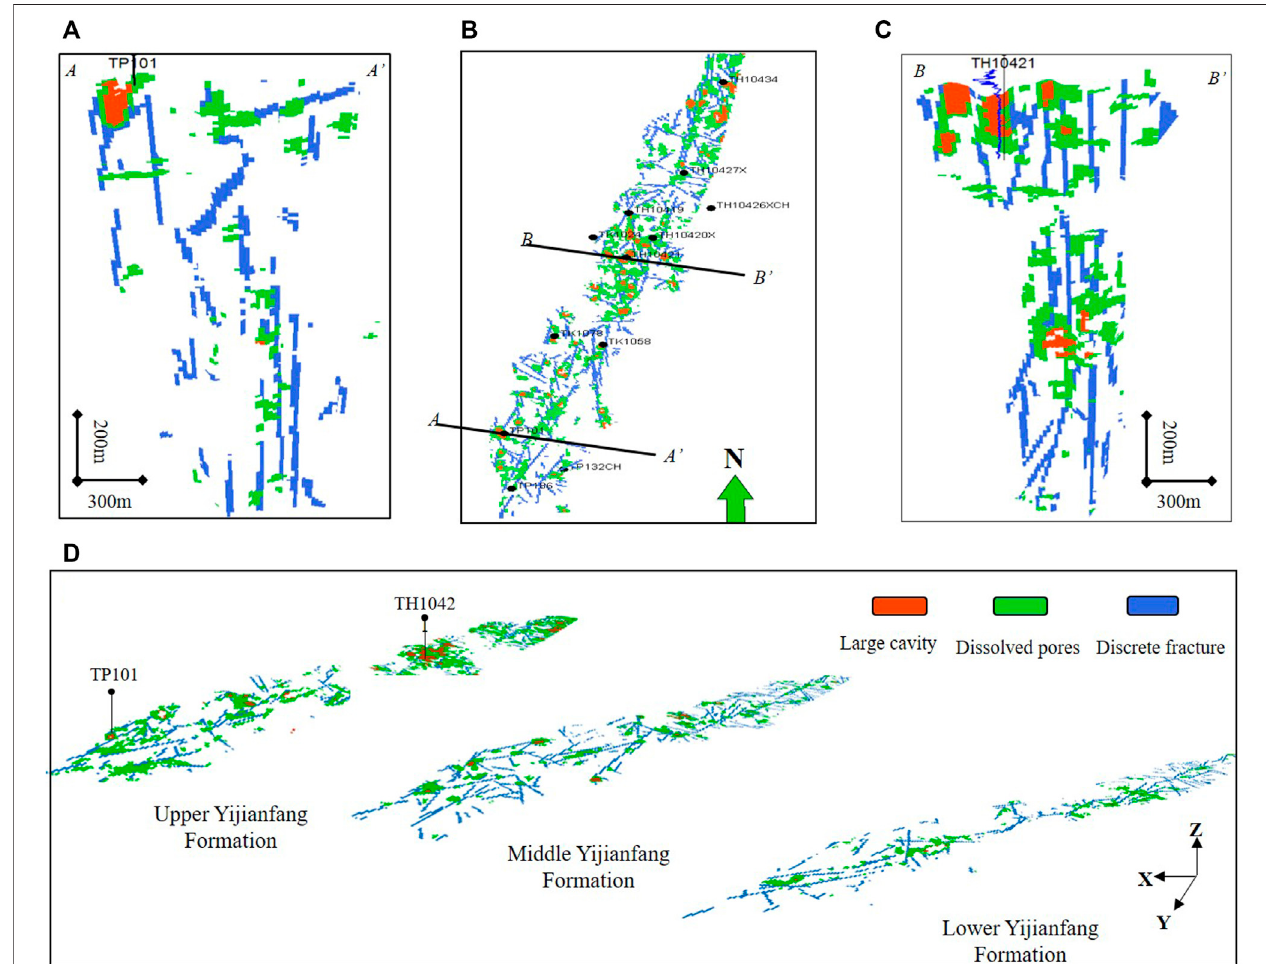
FIGURE 9 | Fault-controlled paleokarst internal elements models in the TP12CX units. (A) The model pro fi le of the TP101 well; (B) The results of the plane distribution of fracture-cavities; (C) The model pro fi le of the Th10421 well; (D) Evolution of fracture-cavities.